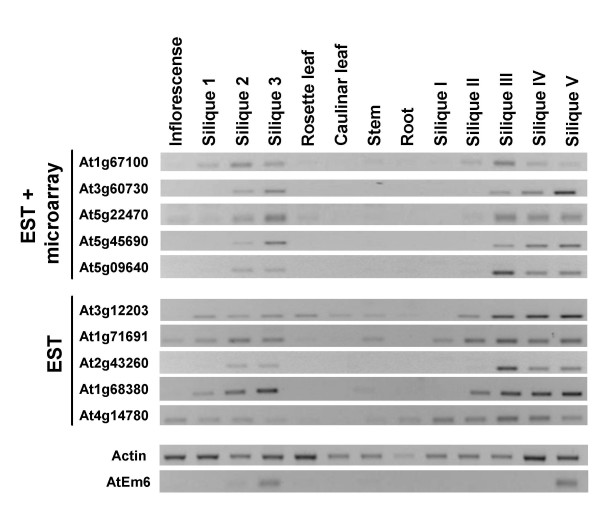
RT-PCR analysis of the expression profiles of ten genes isolated by in silico screening. "EST + microarray" indicates genes isolated by the combination of EST selection and microarray data analyses. "EST" indicates genes isolated only by EST selection. Siliques 1 to 3 correspond to whole siliques at different stages of development (1, young green; 2, green fully developed; 3, desiccating siliques). Siliques I to V correspond to siliques at different stages of development (I, 0–4 daf; II, 4–8 daf; III, 8–12 daf; IV, 12–16 daf; V, 17–21 daf). In each case, the size of the bands was as expected.